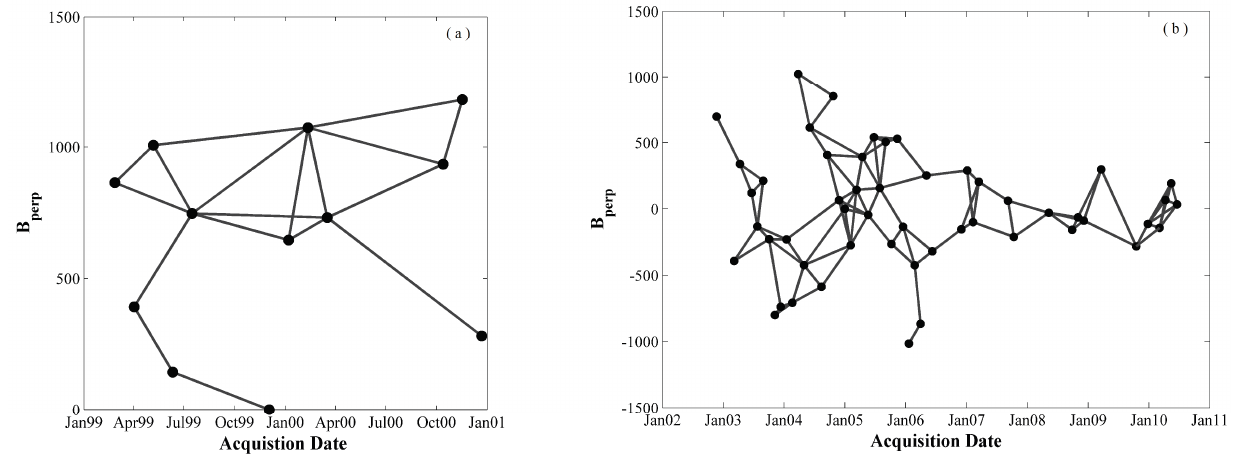
Figure 2. Temporal (X-axis) and perpendicular (Y-Axis) baselines. Black dots represent the SAR acquisitions and the grey lines the interferometric links. ( a ) ERS data; ( b ) ENVISAT